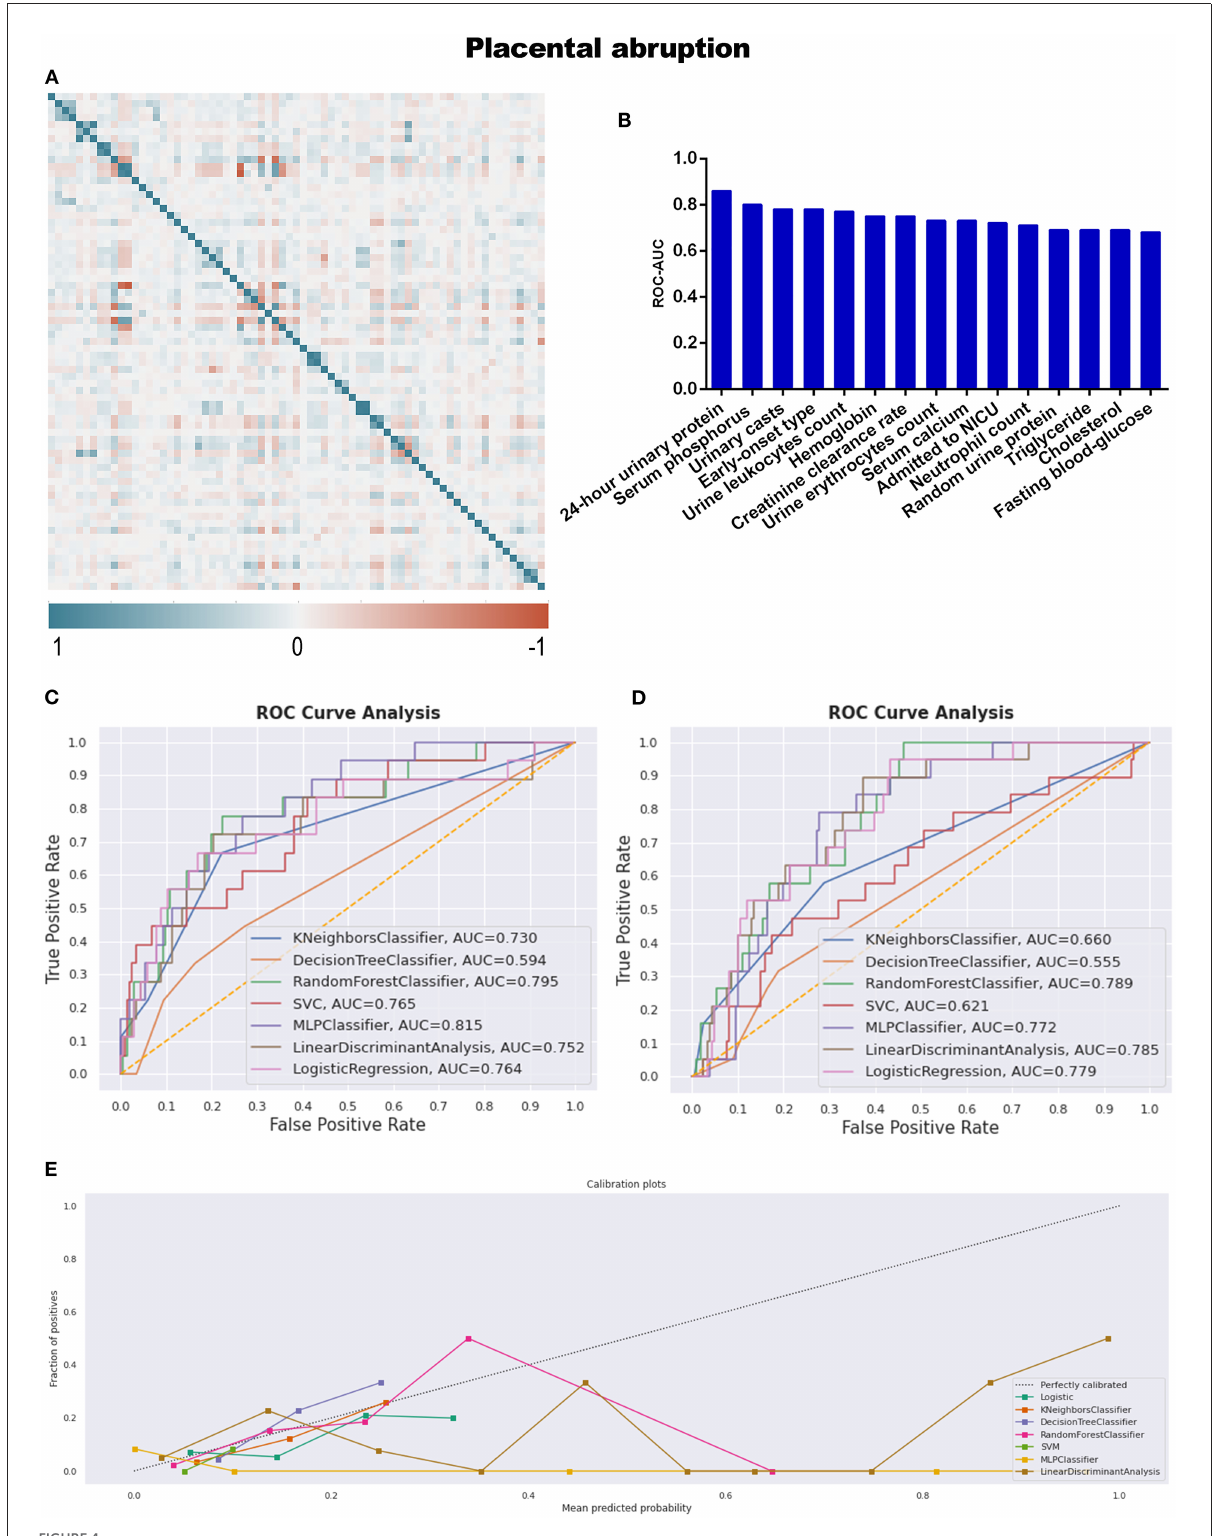
FIGURE4 (A) The generated heat map according to correlation analysis to screen independent variables for adverse events; (B) feature selection of Top 15 adverse outcomes predictive variables according to the value of AUC calculated by DT algorithm; (C) the ROC-AUC values of machine learning and logistic regression predictive models developed from the imputed dataset; (D) the AUC values of models developed from the dataset without imputation; (E) the calibration curve generated from the models developed from imputed dataset. Referring to the adverse outcome of placental